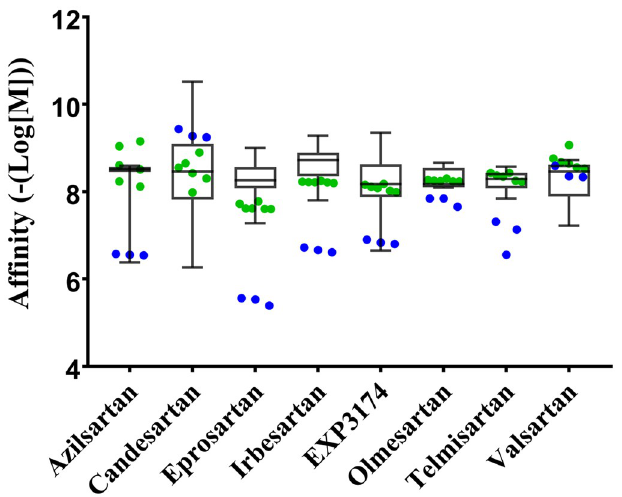
Fig 6. Docking ARBs to the apo-AT 1 R model. Original AutoDock 4.2 parameters (blue points) and optimized docking parameters (green points) are overlaid on a box and whisker plot of experimentally derived ARB affinity [21]. The whiskers represent the maximum and minimum affinity, and the box represents the second and third quartiles with the line representing the median.